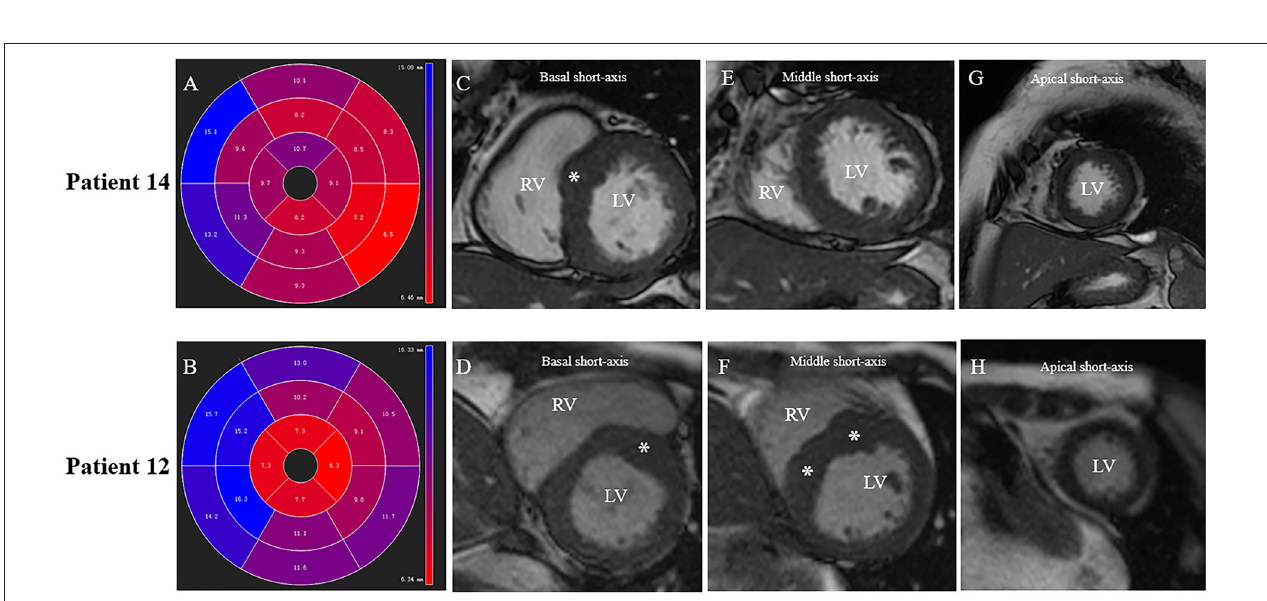
FIGURE 4 | Different patterns of septum hypertrophy among patients. Patient No.12: (B,D,F,H) . Patient No.14: (A,C,E,G) . (A,B) CMR end-diastolic images demonstrating different patterns of interventricular septum hypertrophy. The distribution of LV hypertrophy is limited (basal anteroseptal segment) in (A) , while diffused (basal, mid anteroseptal, and mid inferoseptal segments) in (B) . (C,D) Short-axis view presents a segmental LV hypertrophy of the basal anterior septum in both patients. (E,F) Both mid anteroseptal and inferoseptal segments are free of hypertrophy in (E) , but present hypertrophied phenotype in (F) . (G,H) Apical septal segment is free of hypertrophy in both